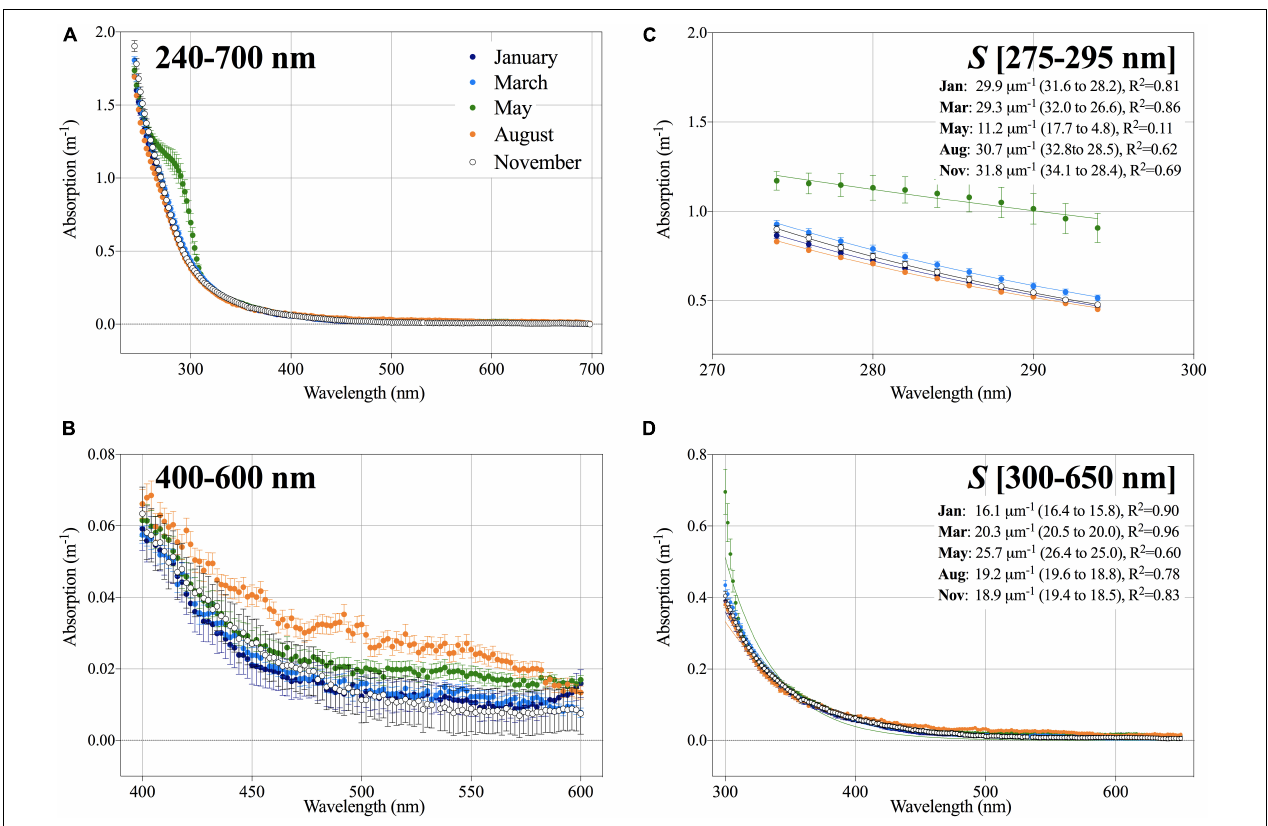
FIGURE 3 | (A) Absorption (m − 1 ) from 240 to 700 nm shown as average ± SE calculated for the upper 100 m in January (dark blue), March (light blue), May (green), August (orange), and November (white). (B) Absorption spectra from 400 to 600 nm. (C) Absorption spectra from 275 to 295 nm and (D) 300–650 nm fitted exponential function for each month. The slopes are given as well as the 95% confidence interval and the R 2 for the non-linear fit.